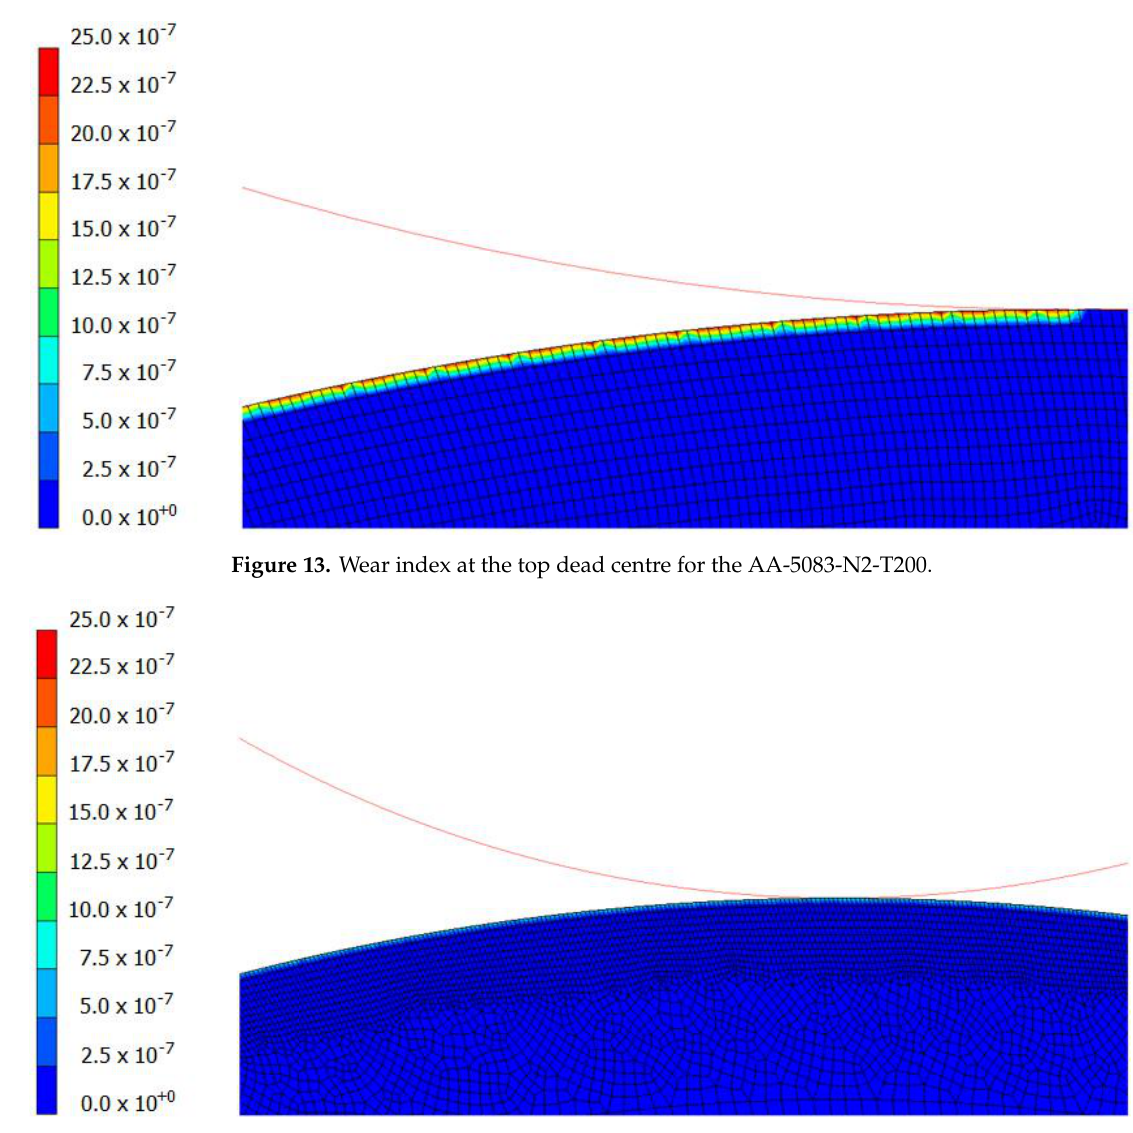
Figure 14. Wear index at the bottom dead centre for the AA-5083-N2-T200.